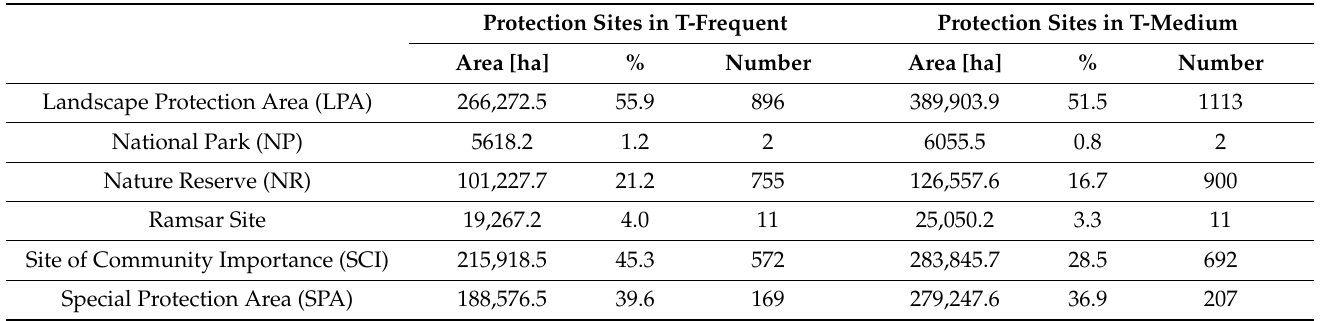
Table 4. Extent and number of protection sites for T-frequent and T-medium. Protection Sites in T-Frequent Protection Sites in T-Medium Area [ha] % Number Area [ha] %